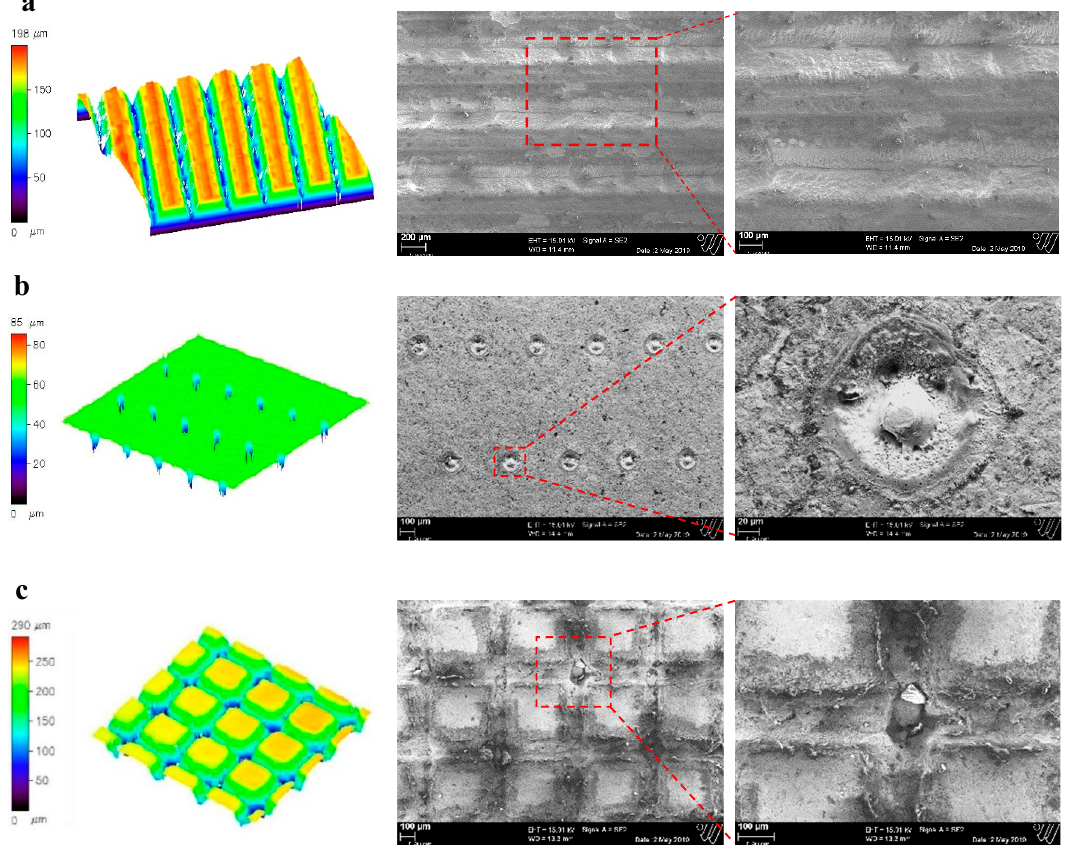
Figure 2. 3D White light interferometry (left) and SEM images (middle and right) of the structured carbide surfaces having ( a ) Grooves, ( b ) Holes and ( c ) Grid.